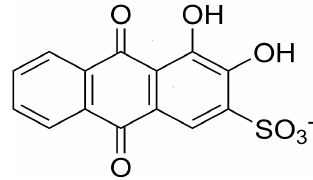
Figure 1. Chemical structure of ARS.